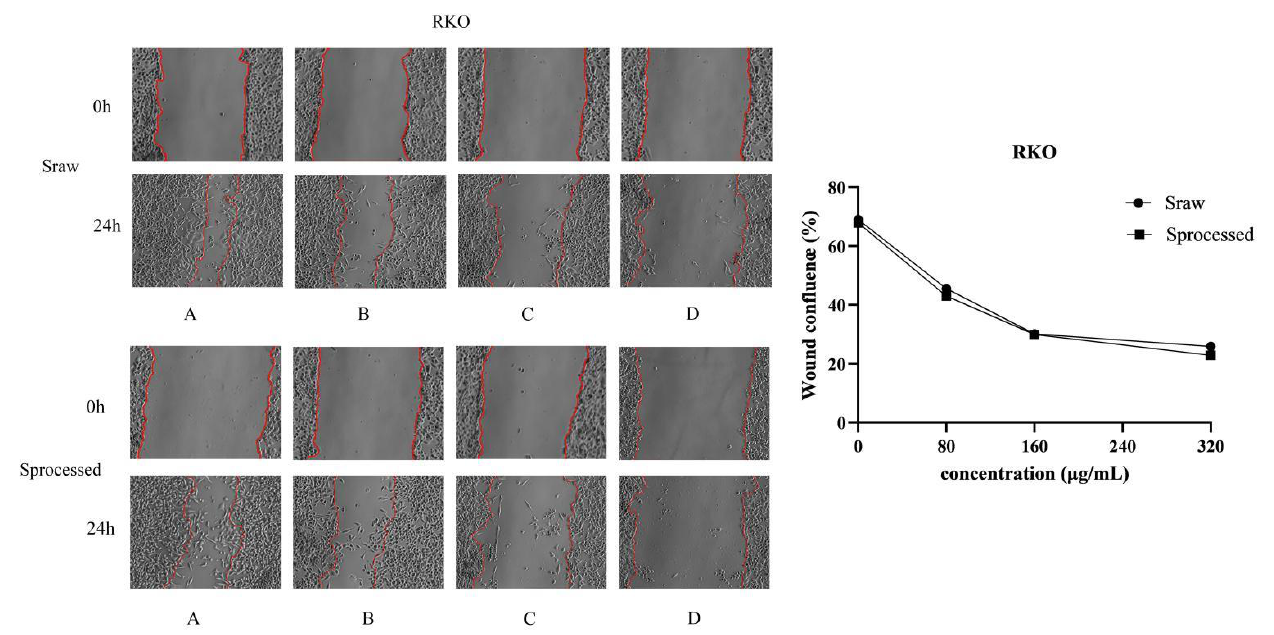
Figure 11. Wound healing assays in RKO cells showing inhibition by Sraw and Sprocessed (scratch analysis). A : 0 μg/mL ; B : 80 μg/mL ; C : 160 μg/mL ; D: 320